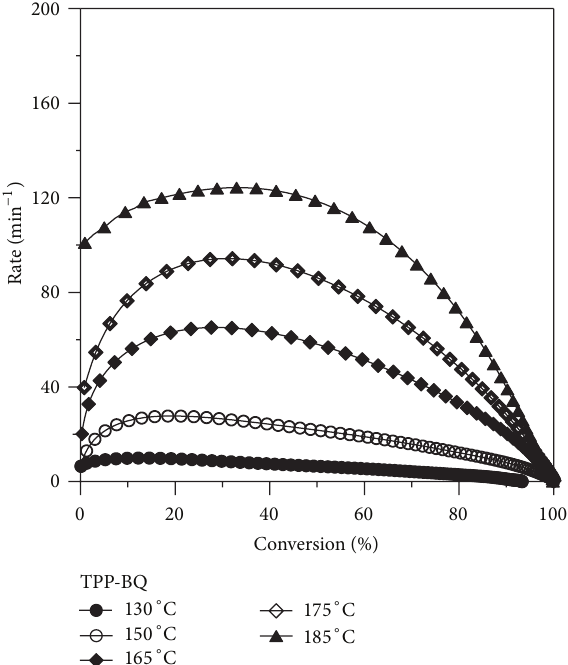
Figure 7: Plots of the reaction rate versus conversion for TPP-BQ- cured EMCs at isothermal